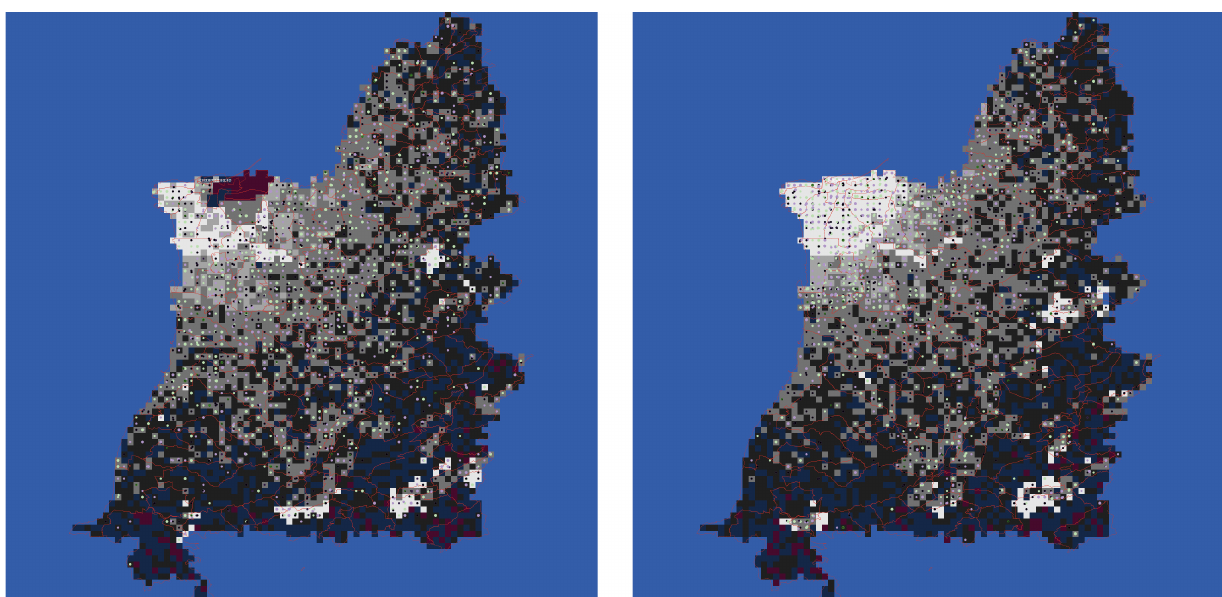
Figure 5. Six months after the explosion (left); same time point in no‐explosion scenario (right).